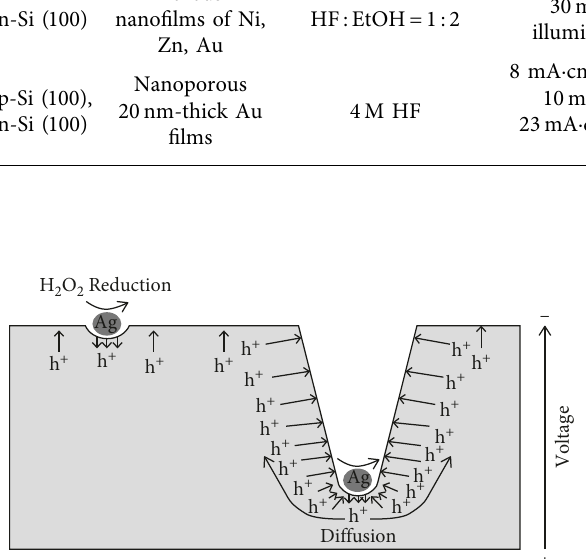
Figure 10: The model illustrates the etching mechanism of the metal–catalyzed electrochemical etching (MCECE) [53] under the terms of the creative commons CC by (Figures 11(a) and 11(b)), and MAECE (Figures 11(e) and 11(f)), the authors [53] emphasize that the main difference of the latter method lies in the synergism of the activating action of the metal and the external electric field. This allows the controlled PSi formation with a wide range of pore depth and aperture size.